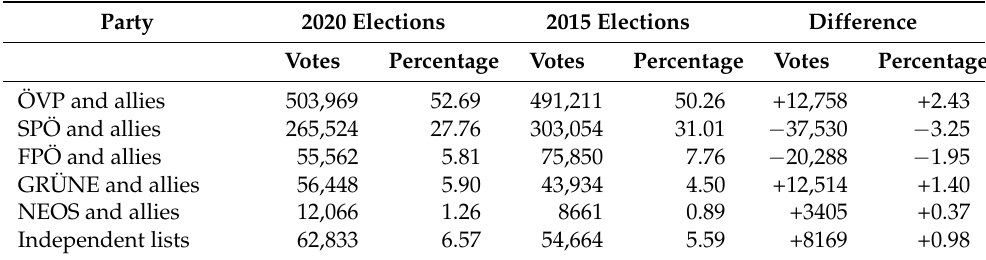
Table 1. Results of the 2020 and 2015 municipal elections in Lower